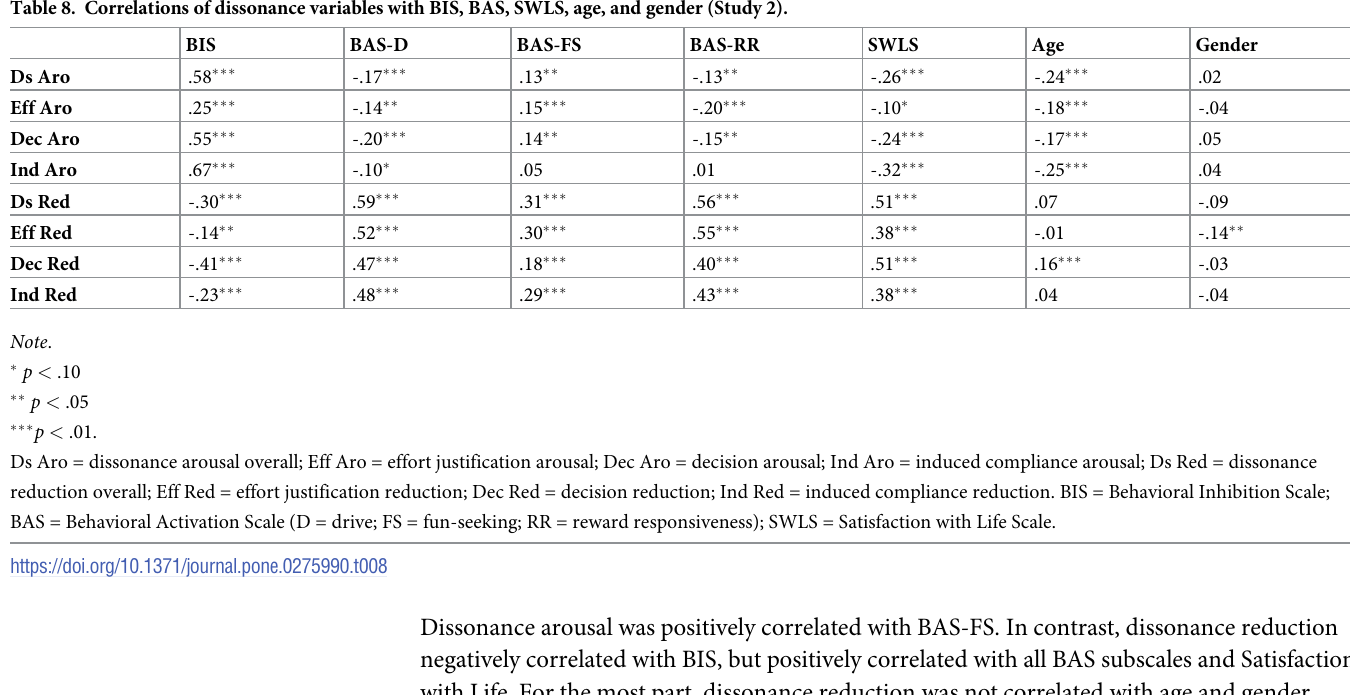
Table 8. Correlations of dissonance variables with BIS, BAS, SWLS, age, and gender (Study 2). BIS BAS-D BAS-FS